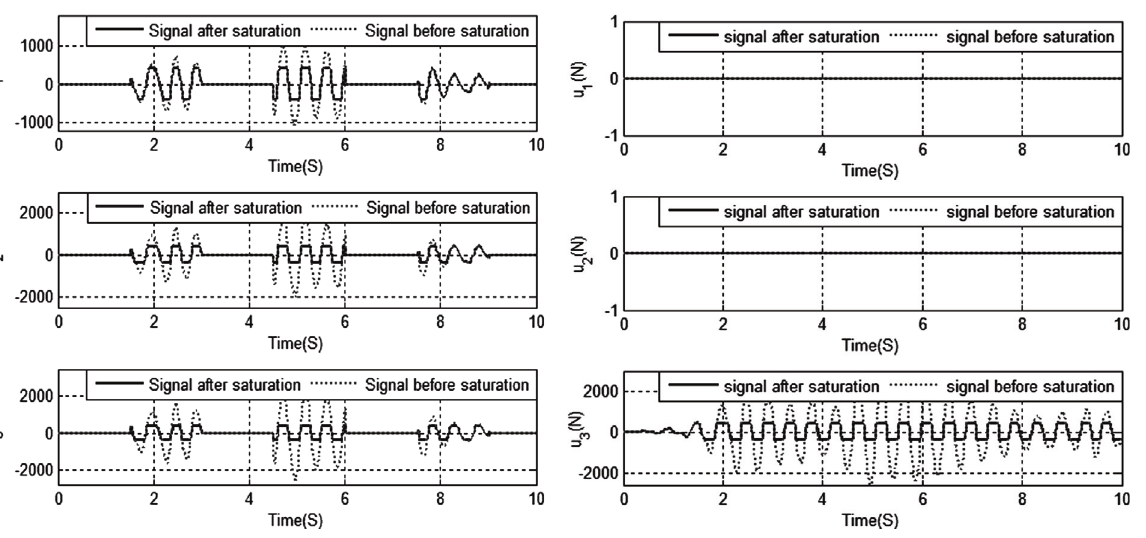
Fig. 11. Displacements of the first floor ( τ = 0 ms).